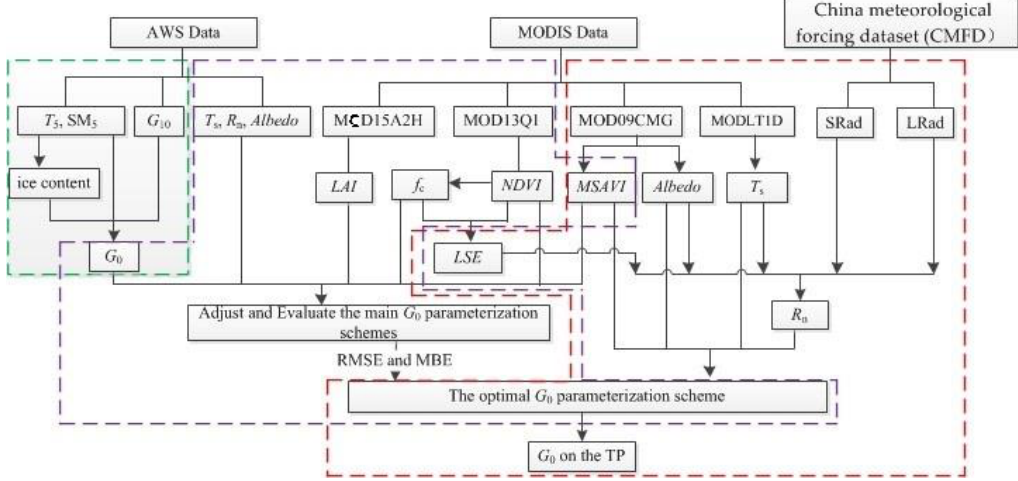
Figure 2. Flow chart used for estimating the ground surface soil heat flux ( G 0 ) on the Tibetan Plateau by combining Moderate Resolution Imaging Spectroradiometer (MODIS data, including MOD15A2H, MOD13Q1, MOD09CMG, and MODLT1D) and meteorological forcing data. Note: T 5 , soil temperature at a depth of 5 cm; SM 5 , 5 cm-depth soil moisture; G 10 , soil heat flux at a depth of 10 cm; T s , land surface temperature; R n , net radiation; Albedo, land surface albedo; LAI , leaf area index; f c , vegetation coverage; NDVI , normalized difference vegetation index; MSAVI , modified soil adjusted vegetation index; LSE , land surface emissivity; SRad, downward shortwave radiation; LRad, downward longwave radiation; G 0 , ground surface soil heat flux.